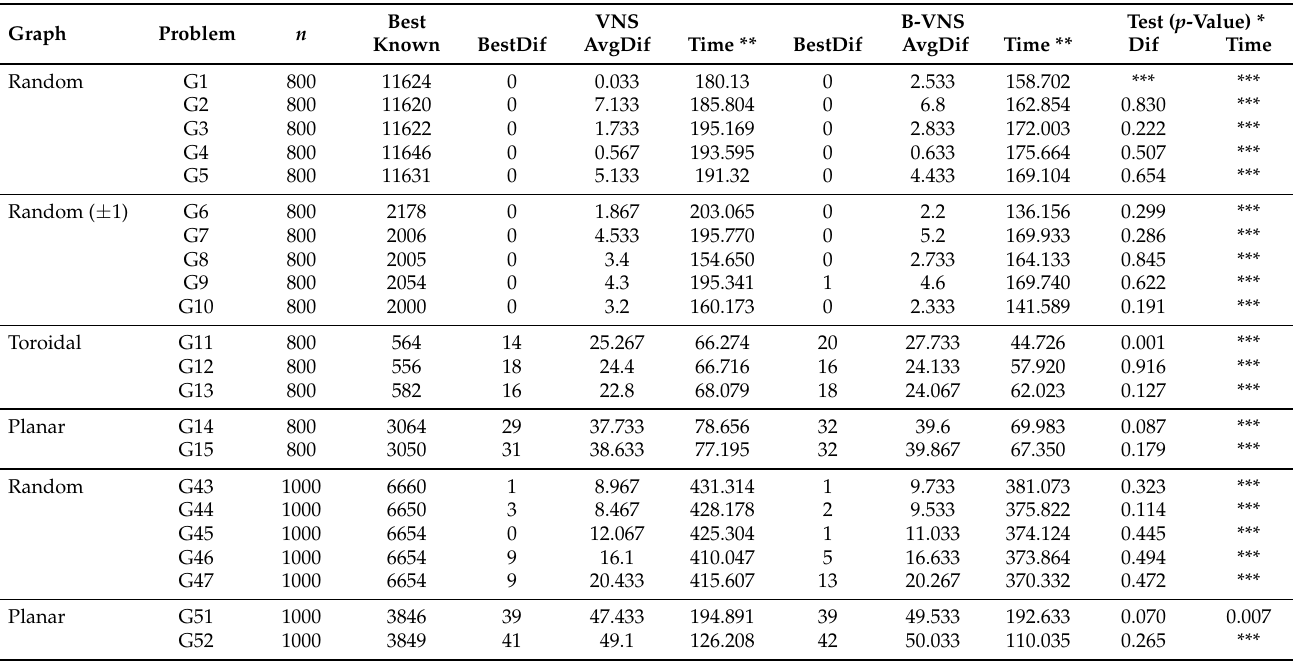
Table 3. Results for Helmberg–Rendl [39]